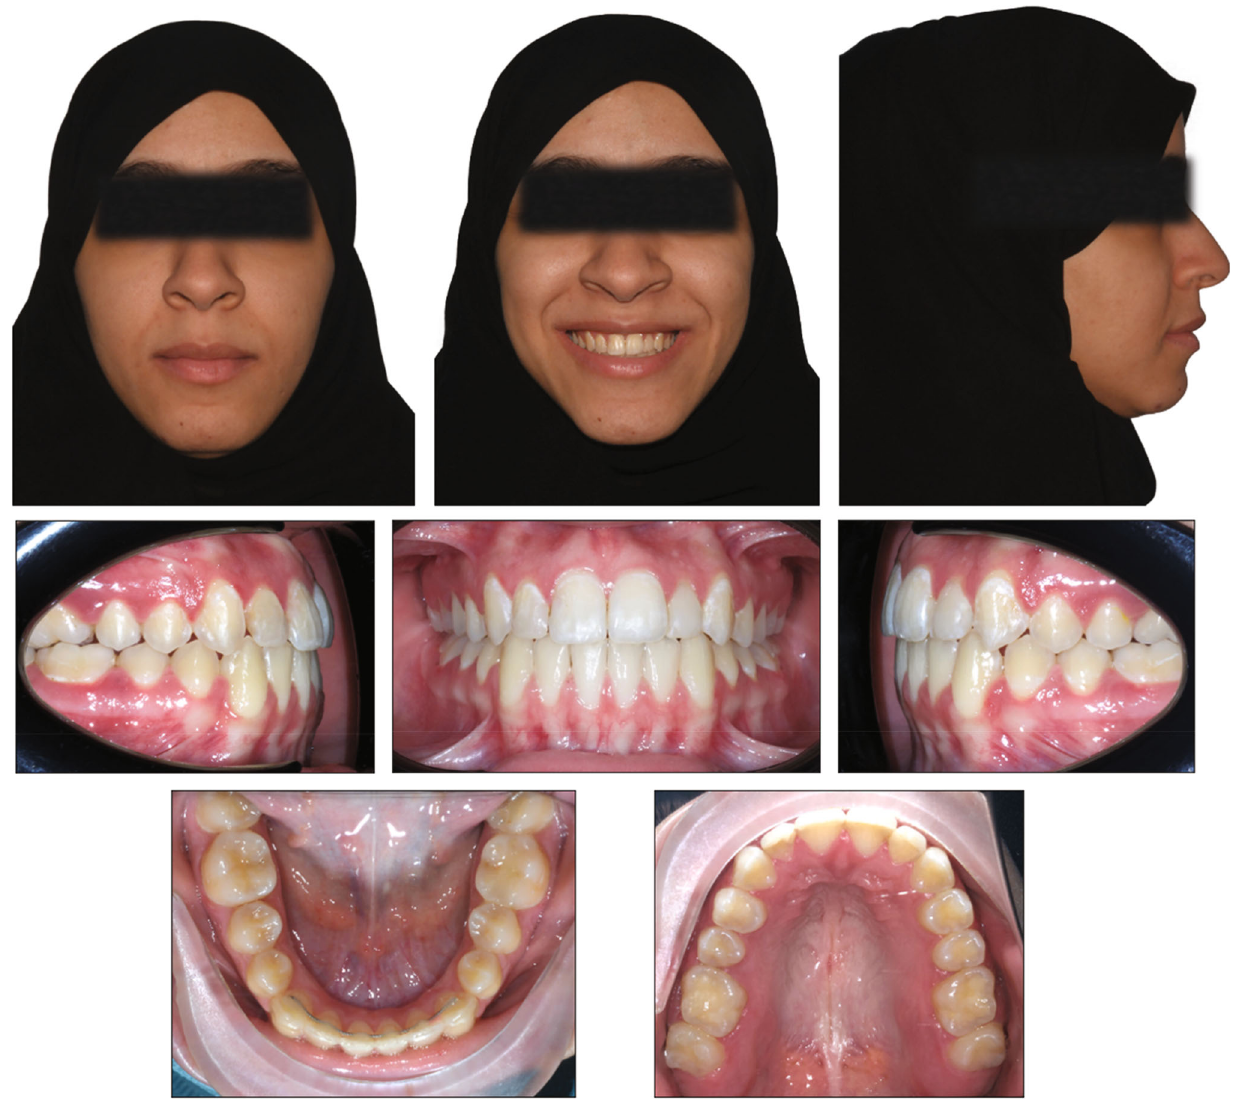
Figure 6: Posttreatment photographs of the